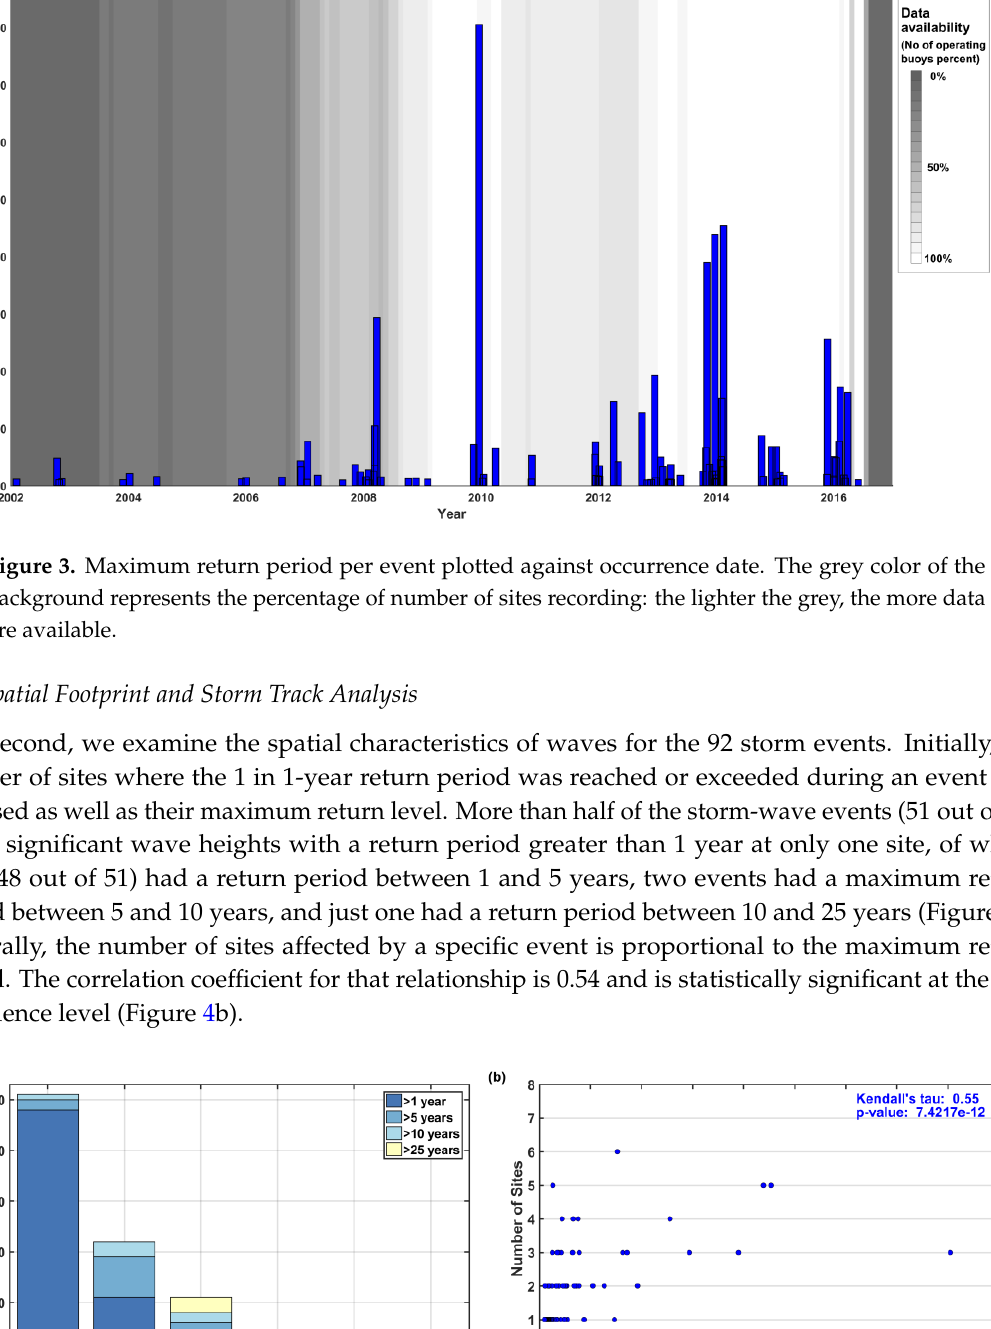
Figure 4. ( a ) Histograms showing the number of sites where the 1 in 1-year return level was exceeded. Events are also sorted by different return period thresholds. ( b ) The return period of the highest significant wave height for the 92 extreme wave events plotted against the number of sites where the 1 in 1-year return level was exceeded.